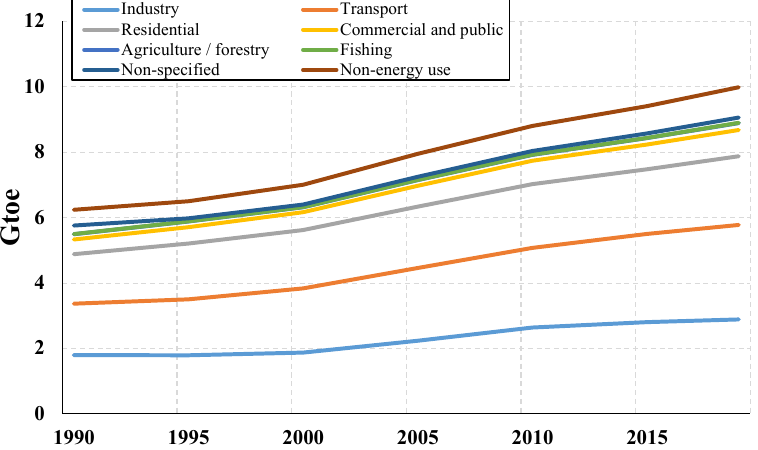
Figure 1. World total final consumption by sector: each curve is stacked with the bottomed others [1].